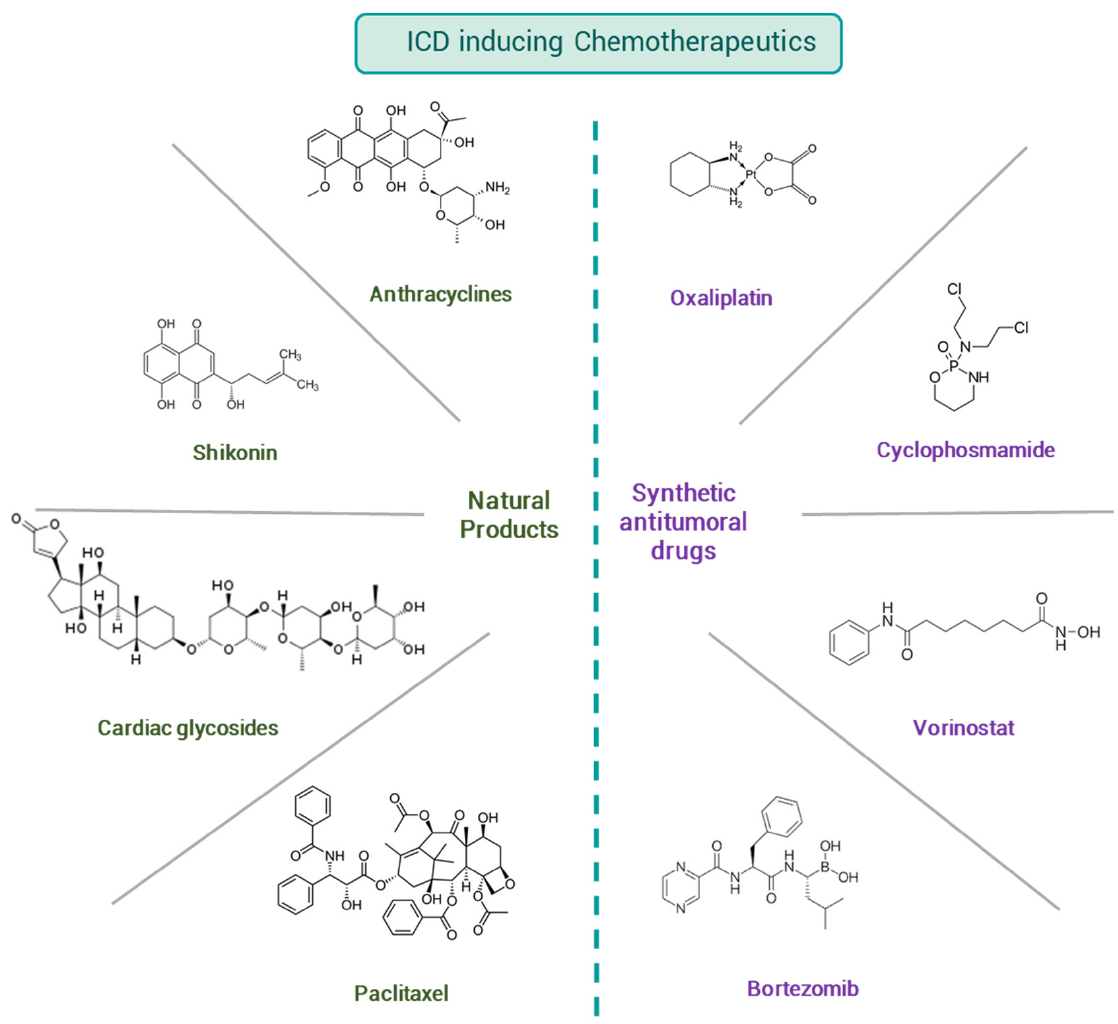
Figure 8. Drugs from natural sources and synthetic approaches that induce